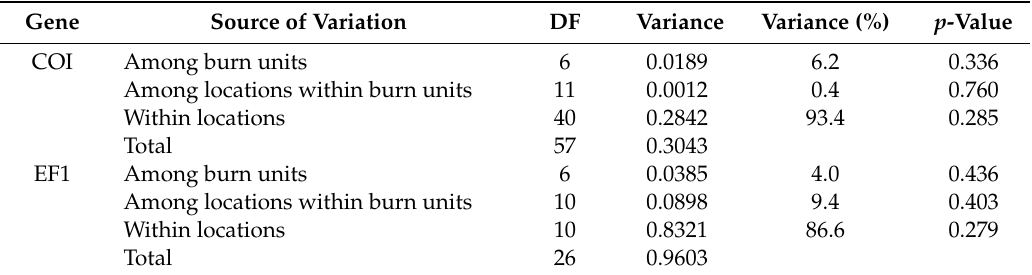
Table 1. Hierarchical test of molecular variance to test for genetic variation in COI (n = 58) and EF1 (n = 27) genes associated with burn unit and locality for field collected egg case samples of C. thomasi bethunebakeri. Gene Source of Variation DF Variance Variance (%) p